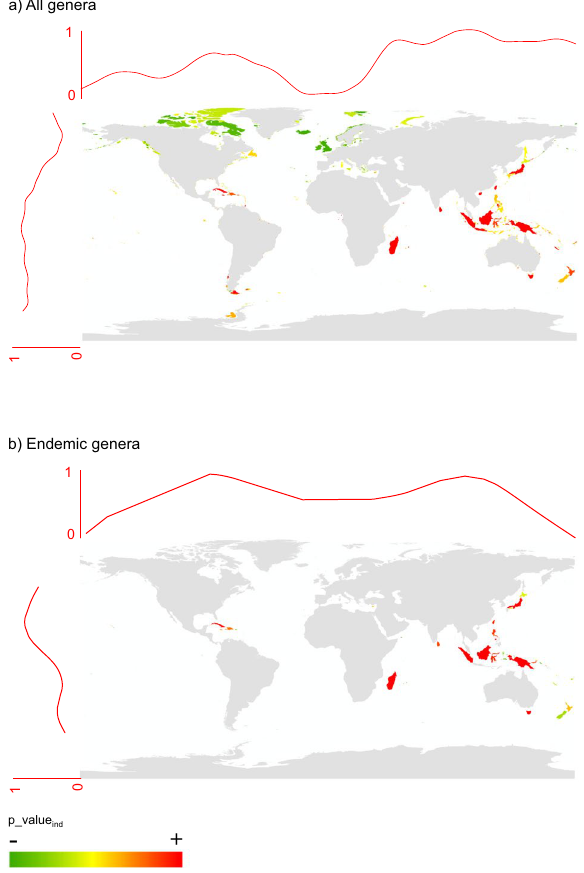
Figure 3. Spatial distribution of islands where ExpPD loss is higher than expected at random: ( a ) considering all genera; ( b ) considering only genera that are endemic to islands. Curves at the top and to the left of the maps represent the fitted distribution of p-values ind (cubic smoothing spline) along longitudes and